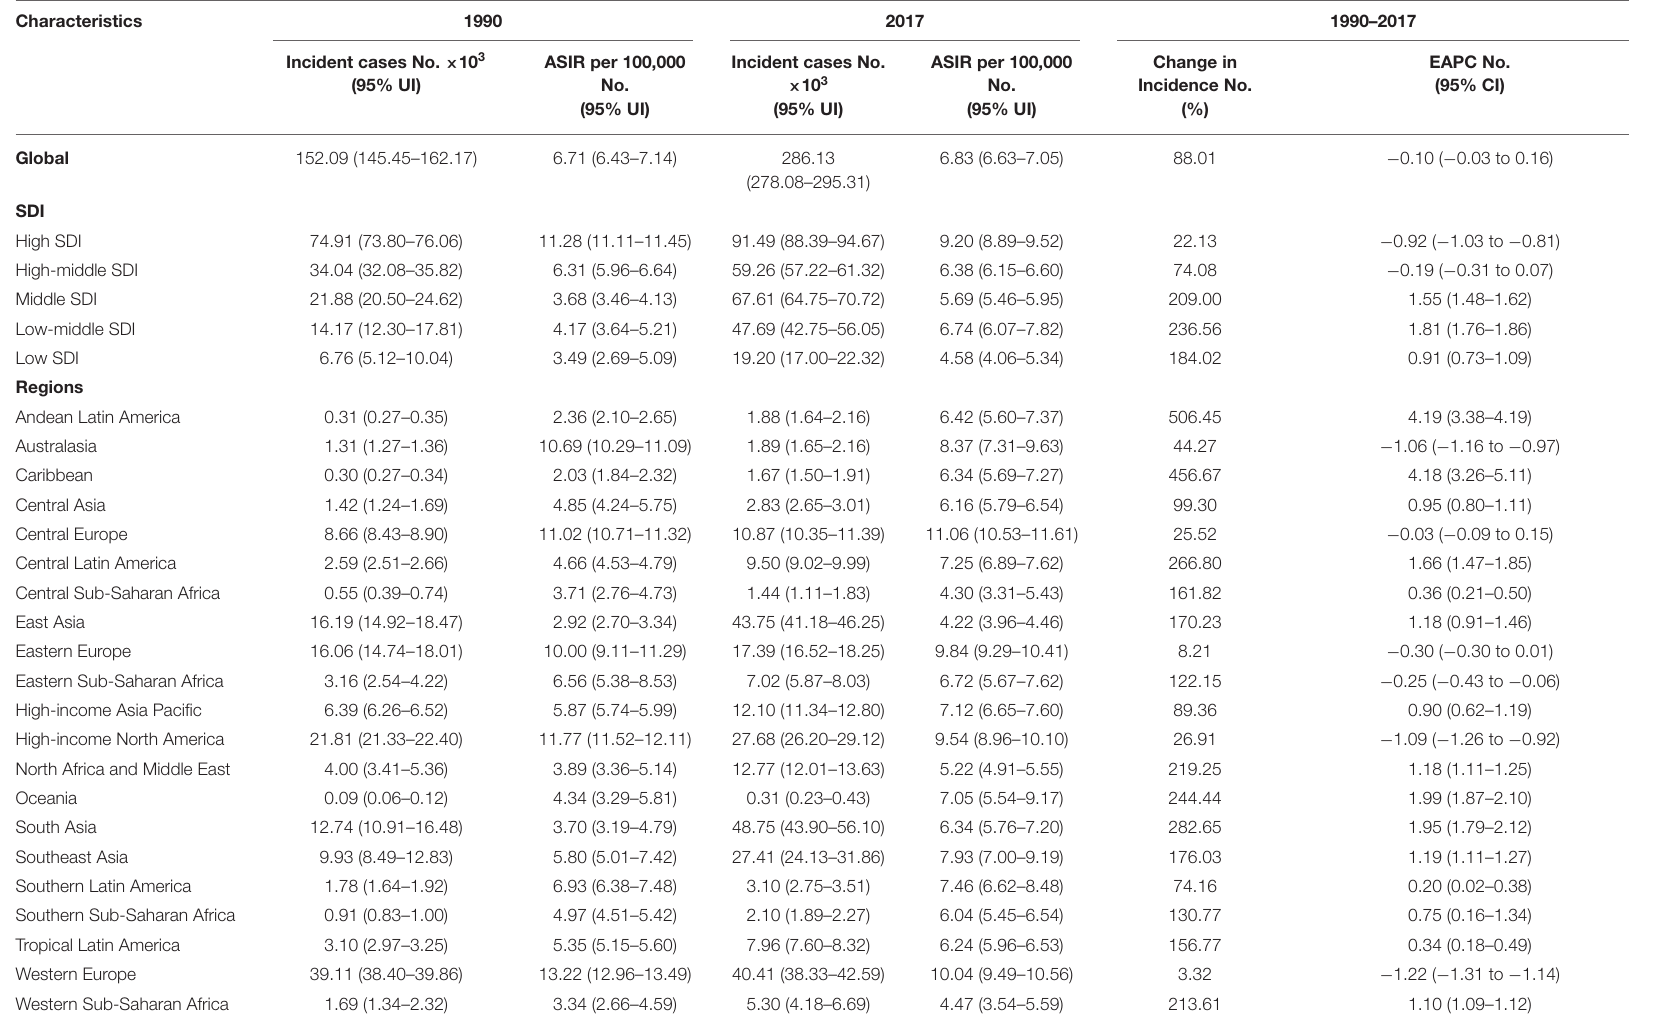
TABLE 1 | The incidence of ovarian cancer, and its temporal trends from 1990 to 2017.